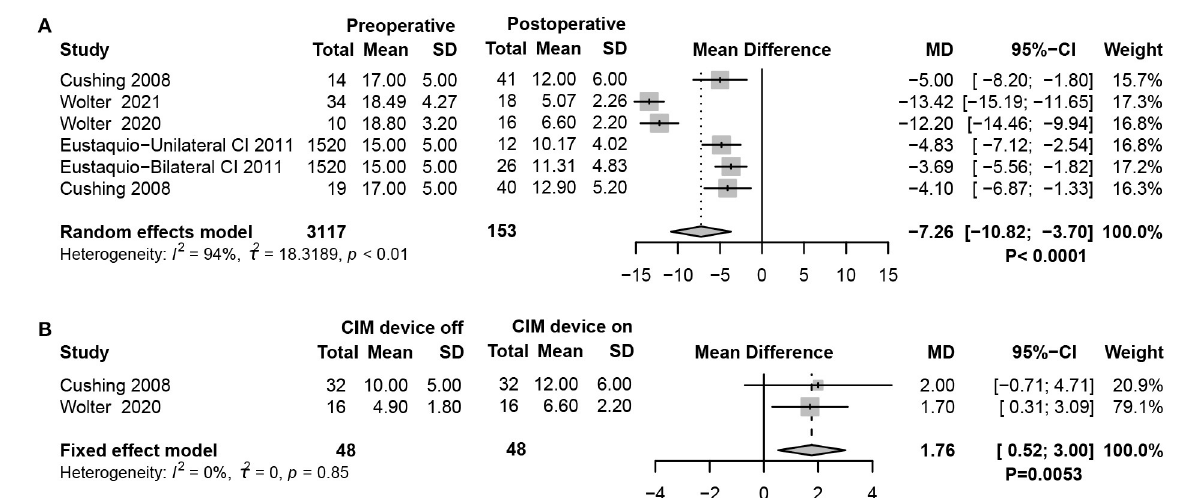
FIGURE5 Forest plots showing balance function test results between pre- and post-surgery groups. (A) BOT-2 test scores. (B) Comparison of the balance function between CIM devices switched on and off. Study, included studies for Research on meta-analysis; Preoperative, results of vestibular function test before operation; Postoperative, results of vestibular function test after operation; CIM device off, postoperative results of vestibular function test with CIM devices off; CIM device on, postoperative results of vestibular function test with CIM devices on; Total, total number of patients in the study; Mean, arithmetic mean; SD, standard deviation; MD, mean difference; 95%-CI, 95% confidence interval; Weight, weight of each study in